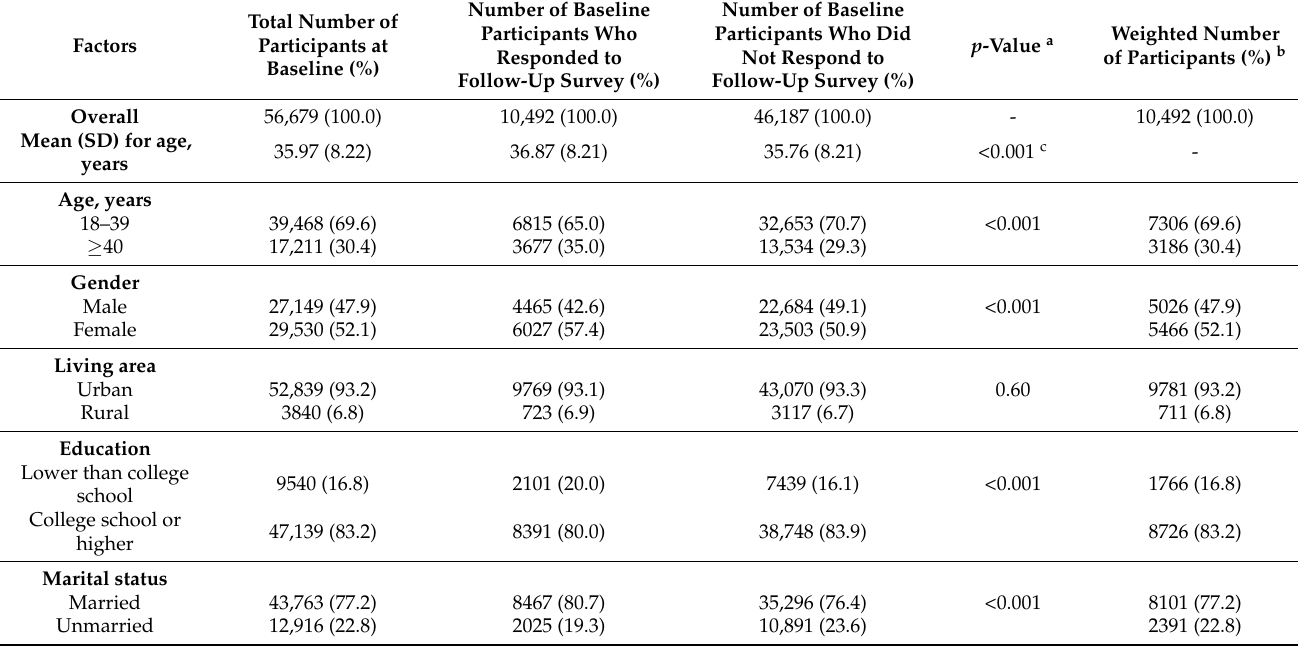
Table 1. Baseline demographic characteristics of